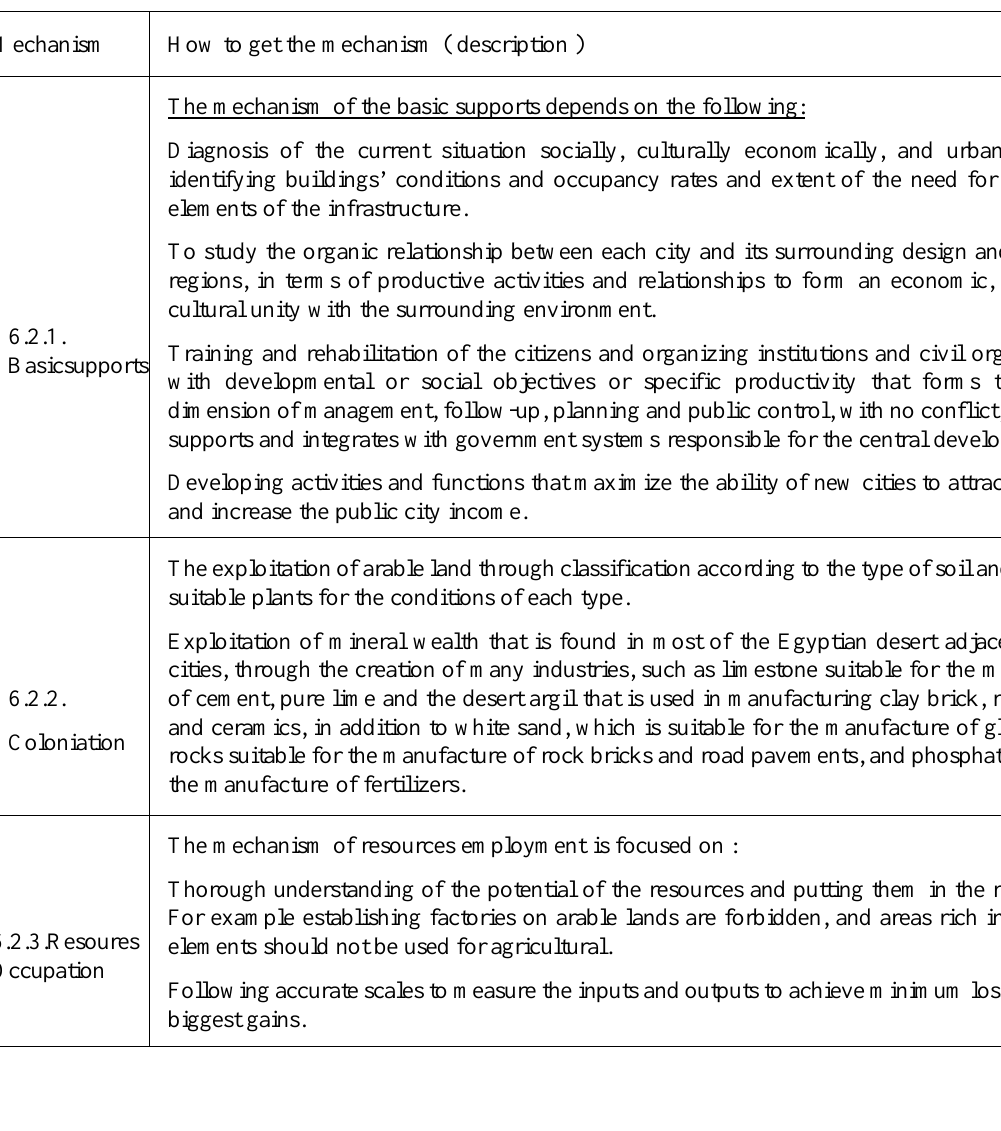
Table 2.Table 2: Shows the development mechanisms for new cities. Source: by the two researchers from Eng. Ali M. Abbas, Azhar Ninth International Engineering Conference. Published paper entitled: The Development of Cities and Regions Random, 2007. Mechanism How to get the mechanism ( description